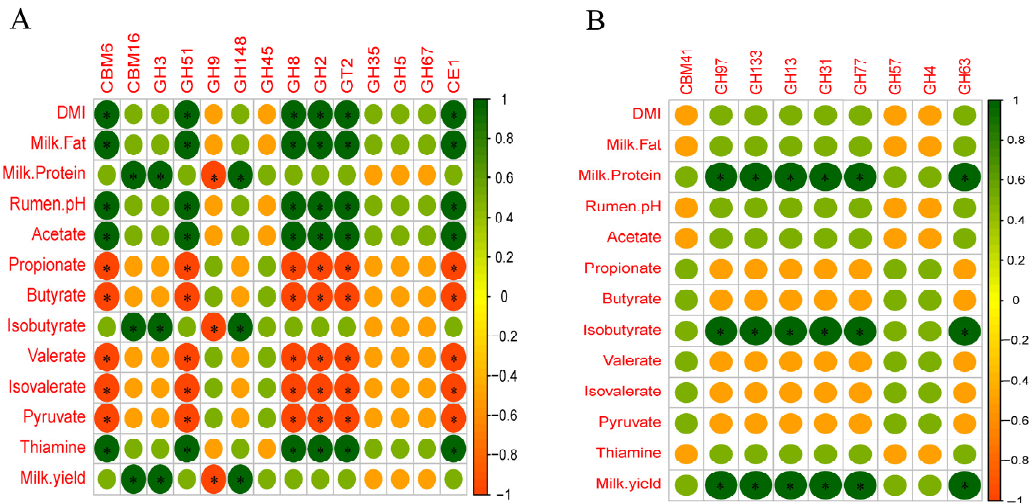
Figure 6. The Spearman correlation analysis between ( A ) fiber-degrading and ( B ) starch-degrading enzymes and animal performance. Green represents positive correlations; red represents negative correlations. “*” Means significant correlations with | r | > 0.5 and p <